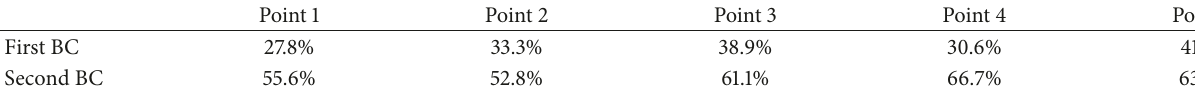
Table 7: The best rejection ratios with varied locations of exciting force.